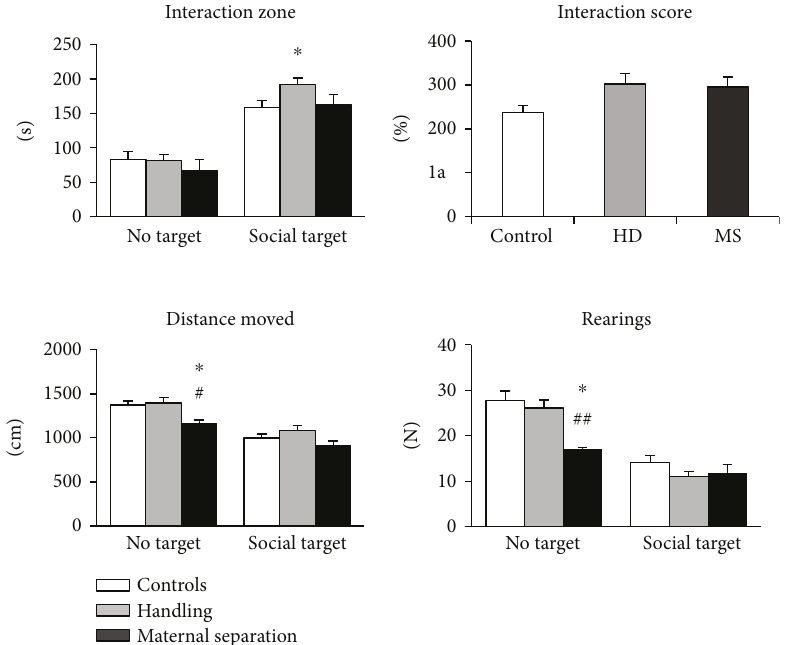
Figure 6: E ff ects of early-life stress on the social behavior of adult male mice. Handling have increased sociability of males, whereas maternal separation had no e ff ects on social behavior. Data present as mean ± standard error of the mean (SEM). White box: controls (males, n = 11 ); grey box: HD (males, n = 10 ), black box: MS (males, n = 6 ); no target: the adaptation trial with an empty target box; social target: the interaction trial with an unfamiliar partner in the target box. ∗ p < 0 05 compared to controls; # p < 0 05 ; ## p < 0 01 compared to